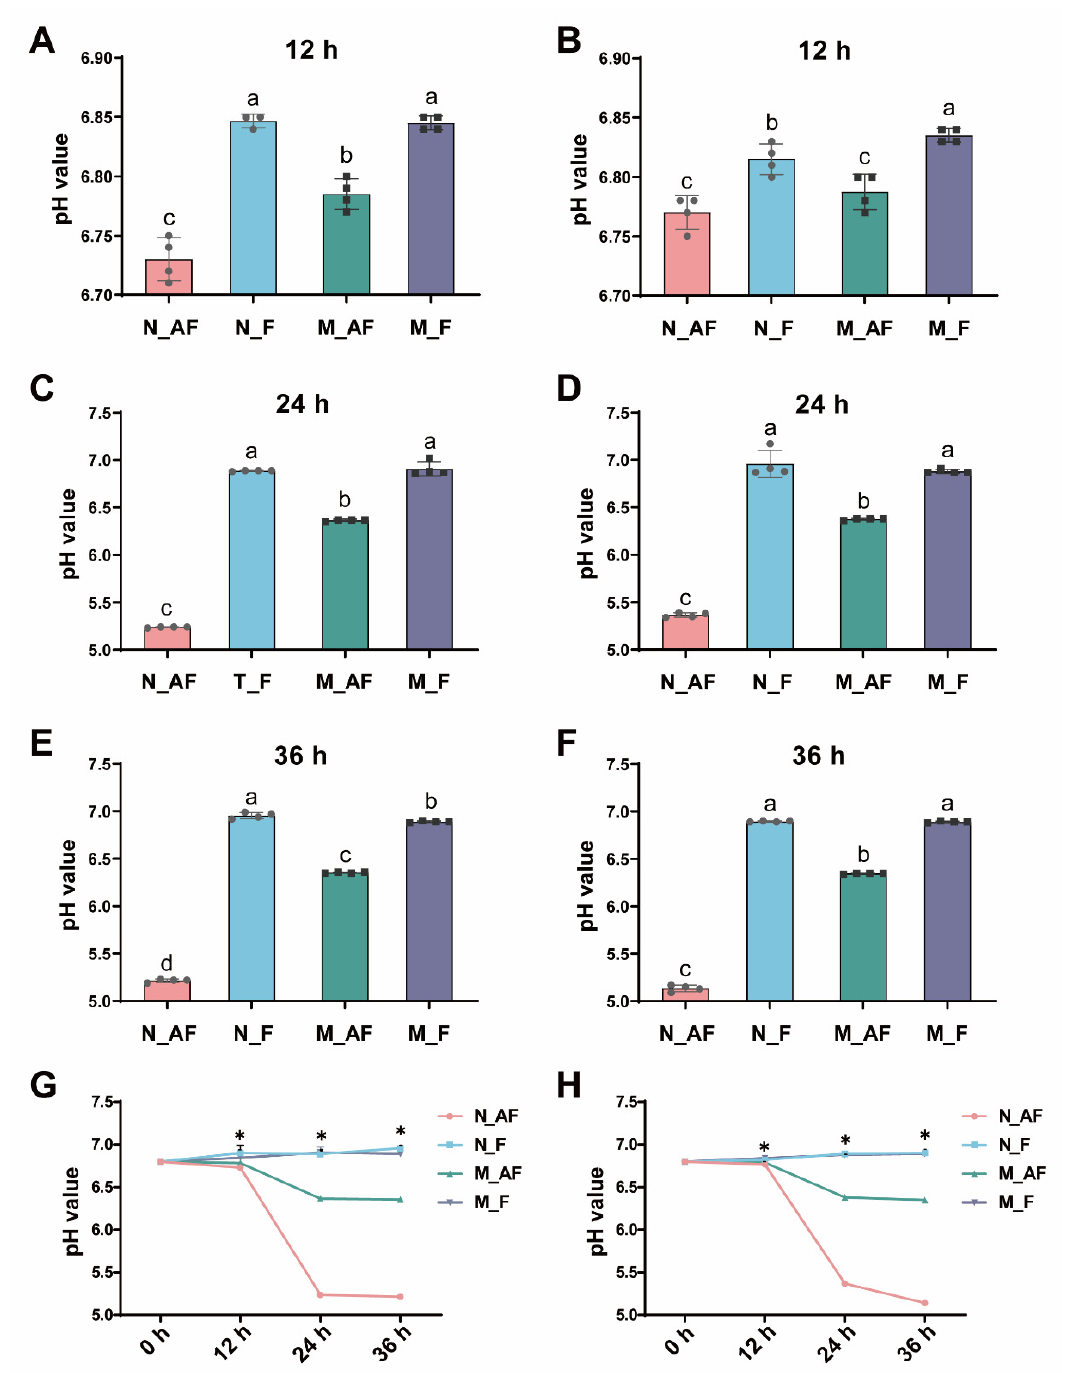
Figure 2. Effect of different treatments on pH of fermentation broth for digesta of Barley diet ( A , C , E ) and digesta of wheat shorts diet ( B , D , F ) at each sampling time and pH changes for digesta of Barley diet ( G ) and digesta of wheat shorts diet ( H ) over time during fermentation. The results presented as the mean values ± SEM. ( n = 4; Different letters mean p < 0.05; * mean p < 0.05. N_AF, normal medium with anti-frozen inoculum; N_F, normal medium with frozen inoculum; M_AF, modified medium with anti-frozen inoculum; M_F, modified medium with frozen inoculum).